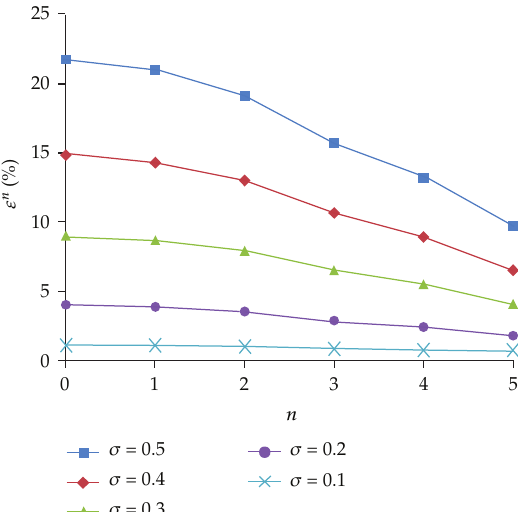
Figure 2: Squared error ratios of asymmetric characterizations of scalar-valued ODFs sampling from N (cid:3) 1 . 0 ,σ 2 (cid:4) in 3D. which can be further reduced